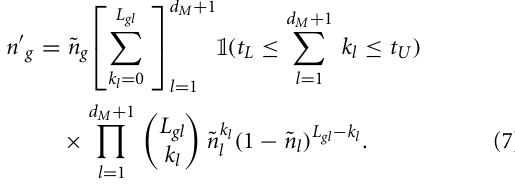
FIGURE 3 | 12-group architecture . (A) The entries L ij of the link matrix, given by equation (2), show the number of neighbors a node v i of group S i has in group S j . For example, the first row of the matrix tells that every node of the singleton group S 1 (denoted by v 1 ) is linked only to nodes of the hole groups S 10 , S 11 , and S 12 , namely to 55, 22, and 2 nodes, respectively. Only nodes of S 6 and S 7 (red box) have links to other nodes of the own group. (B) The architecture generated by this link matrix together with a phenomenological classification into singletons (green), periphery (blue), core (red), and stable holes (black).The lines symbolize the existence of links between nodes of the connected groups, i.e., possible idiotypic interactions between the corresponding clones.The number of links which a node in S i has to nodes in S j is given by the element L ij of the link matrix shown in (A) .The weakly occupied core groups have links within the own groups (open circles).The periphery groups are highly occupied and couple to the core and to the group of stable holes.The group of singletons is highly occupied and couples only to the stable holes.This architecture evolves on the base graph G ( 2 ) 12 for a window [ t L , t U ] = [1,10] and a range of the influx probability p from 0.026 to 0.078. See also